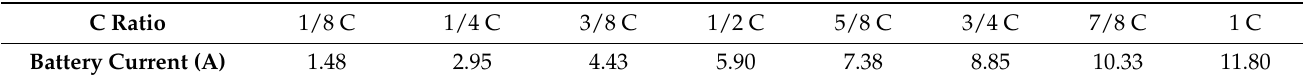
Table 2. Battery discharge